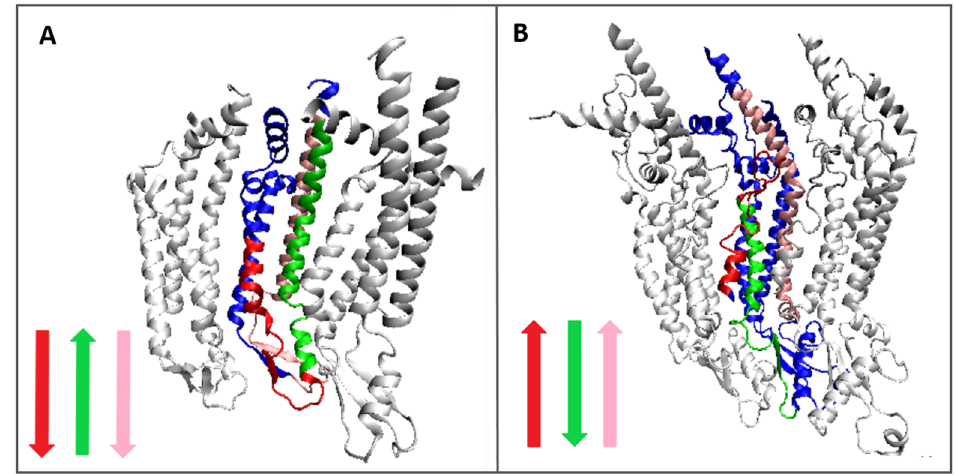
Figure 8. 3D presentation showing the analogous fragments in the complex—( A )—connexin, ( B )—pannexin. Colors identification is given in Table 2. Notice the opposite orientation of the selected fragments shown by color arrows. Chain ( A )—dark blue. The two white chains in each structure visualize the surrounding of the discussed chain. Molecule orientation:—Top—intra-cellular; Bottom—extracellular direction. Colors as given in Table 2 and Figure 7.